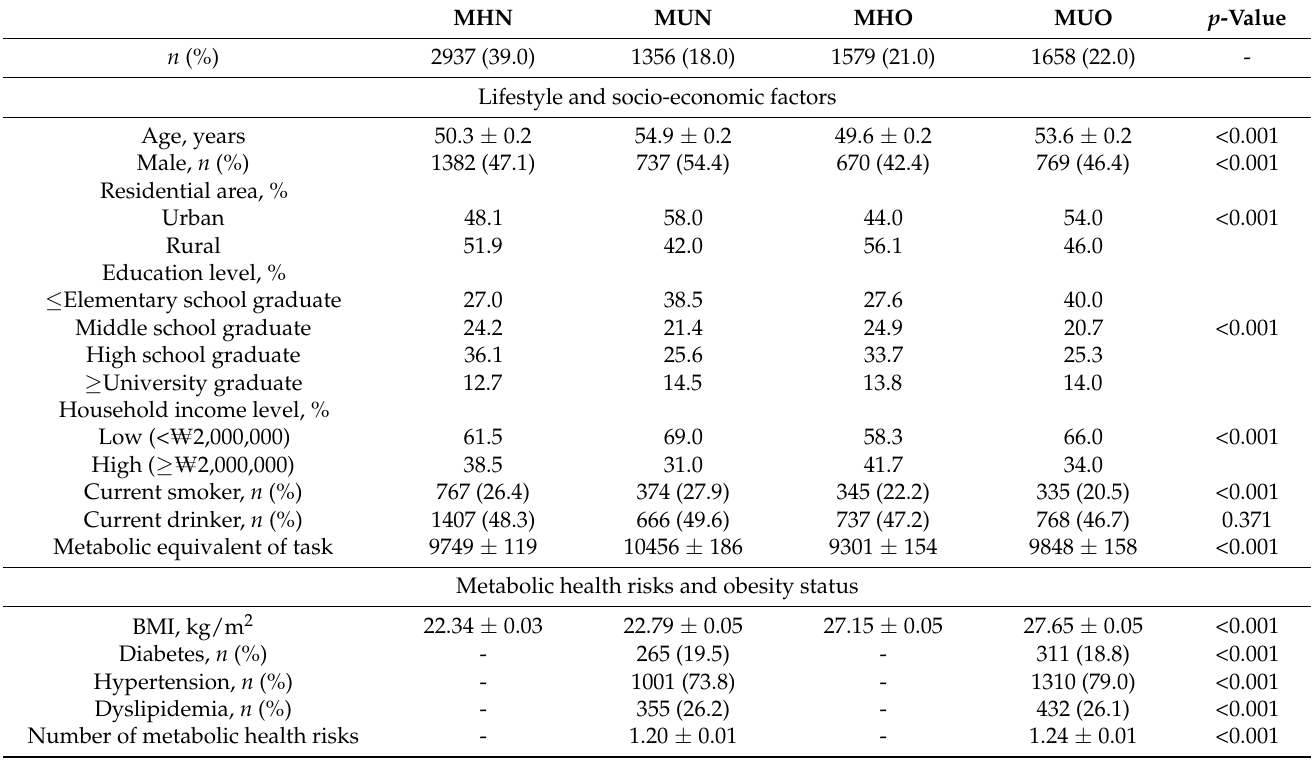
Table 3. Characteristics of study population according to the combination of metabolic health risk and obesity status in KoGES at baseline. MHN MUN MHO MUO p -Value 2937 (39.0) -